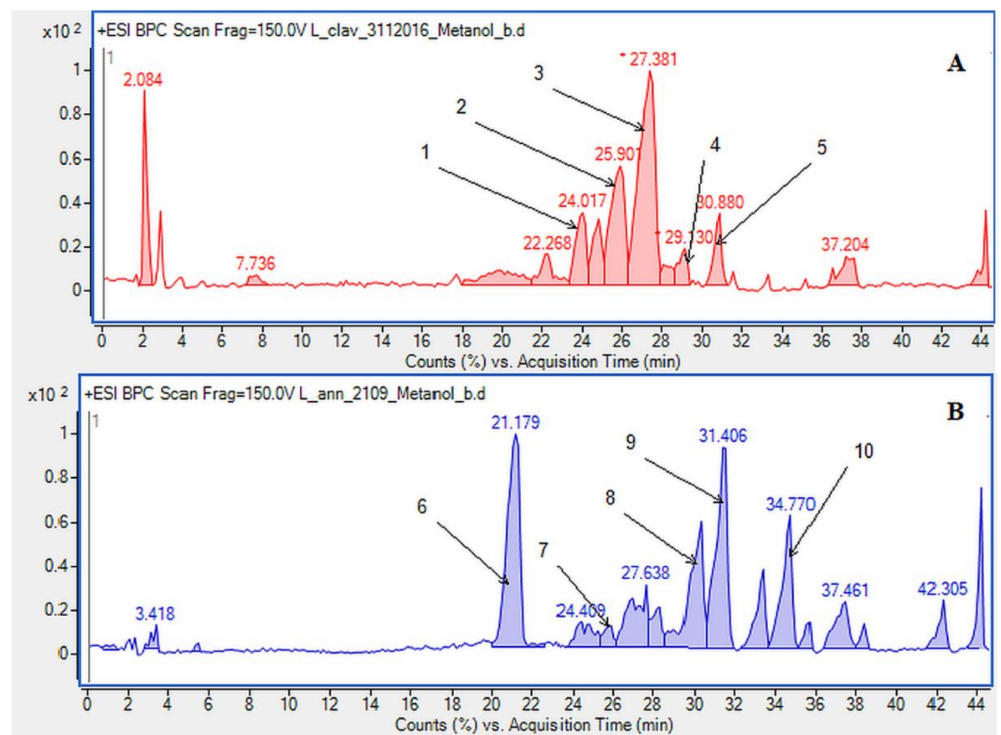
Figure 2. Base peak chromatograms (BPCs) showing the alkaloids identified in the methanolic extracts determined by HPLC/ESI-QTOF–MS in ( A ) Lycopodium clavatum L.: 1. annofoline, 2. dihydrolycopodine, 3. lycopodine, 4. deacetylfacetti- ine and 5. 8- β ,11- α dihydroxylycopodine (or epimer). In ( B ) Lycopodium annotinum L.: 6. annotinine, 7. dihydrolycopodine, 8. acrifoline, 9. annofoline (or epimer) and 10. 8- β ,11- α dihydroxylycopodine (or